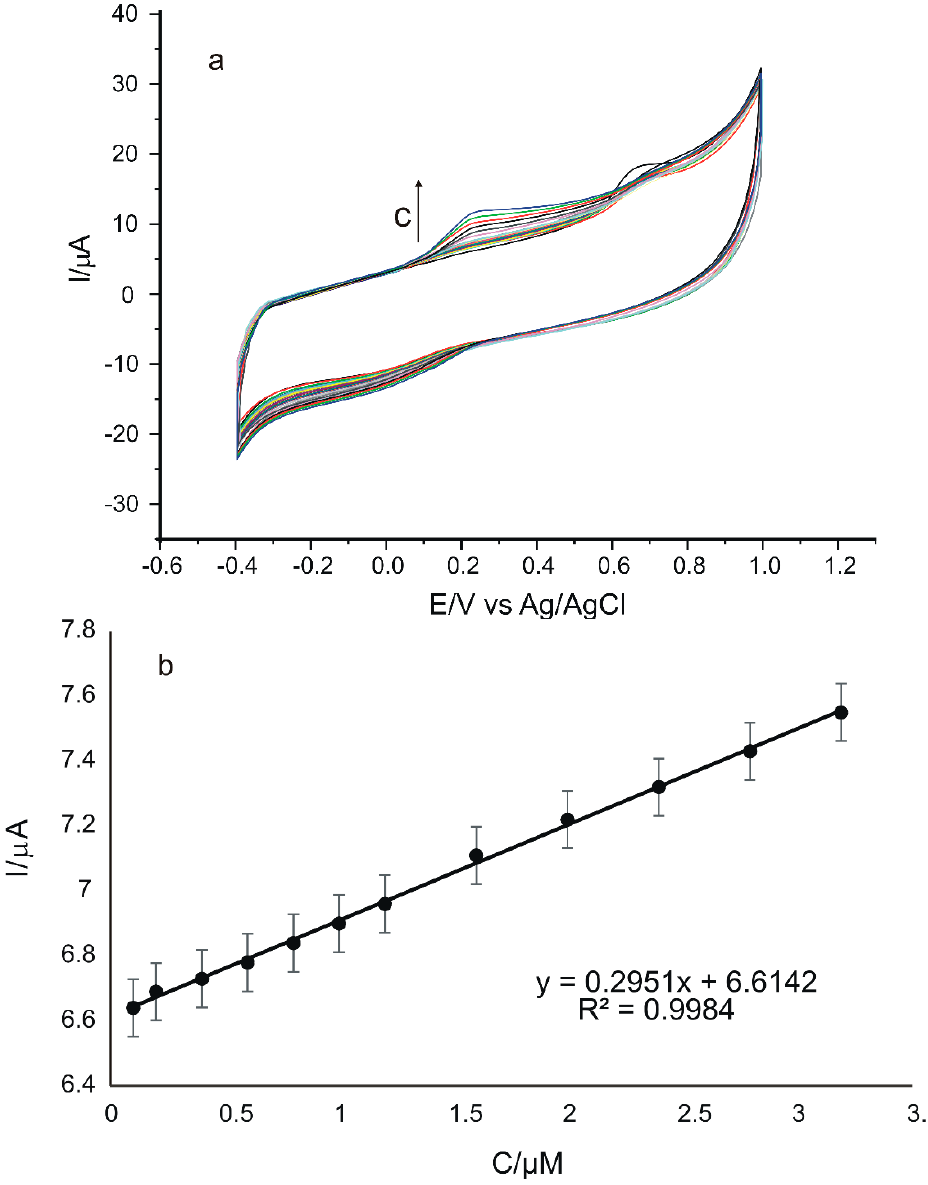
Figure 13. Cyclic voltammograms recorded for GO-Peptide/SPCE with the concentration between 0.1 and 3.20 μ M rosmarinic acid ( a ); Linear dependence between Ipa and rosmarinic acid concentration in the range 0.1–3.20 μ M ( b ).